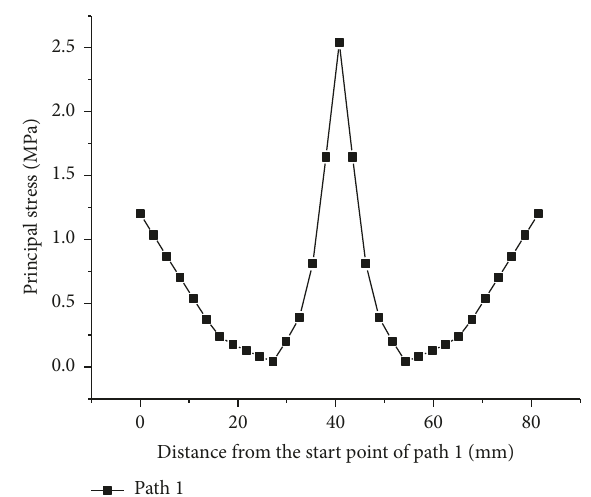
Figure 33: Principal tensile stress in the concrete specimen pre- stressed under a load of 10MPa when the displacement resulting from corrosion-induced expansion reaches 0.031